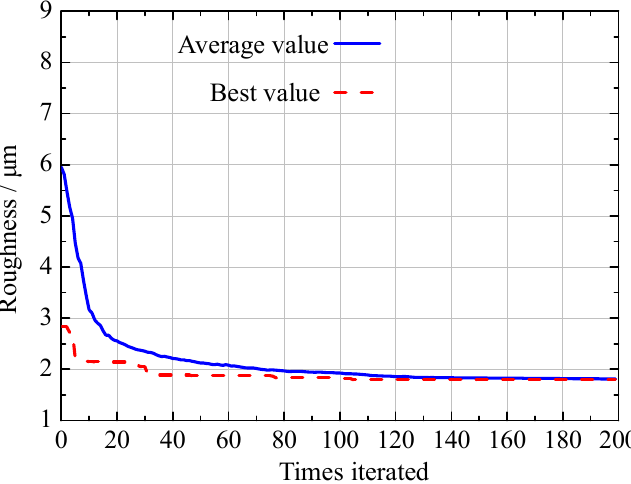
Figure 6. The adaptability variation curve during the optimization process. It can be seen from Figure 6 that convergence was reached after approximately 140 iterations. The obtained minimum roughness of the machined surface was 1.81 μm, and the corresponding cutting speed, cutting depth, rake angle, and rounded edge radius were 11.2 m/min, 0.1 mm, 6.85°, and 11.16 μm, respectively.